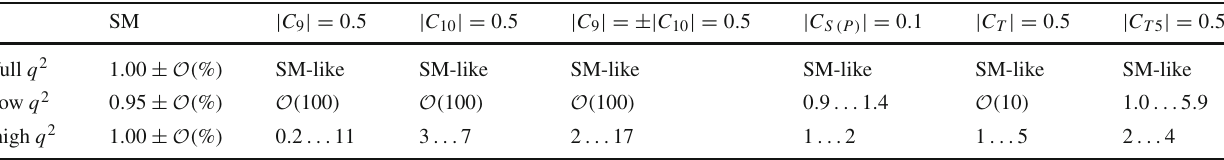
Table 3 R D π (15) in the SM and in NP scenarios for different q 2 –bins. Ranges correspond to uncertainties from form factors and resonance parameters. Due to large uncertainties at low q 2 in some cases only the order of magnitude of the largest values is given SM